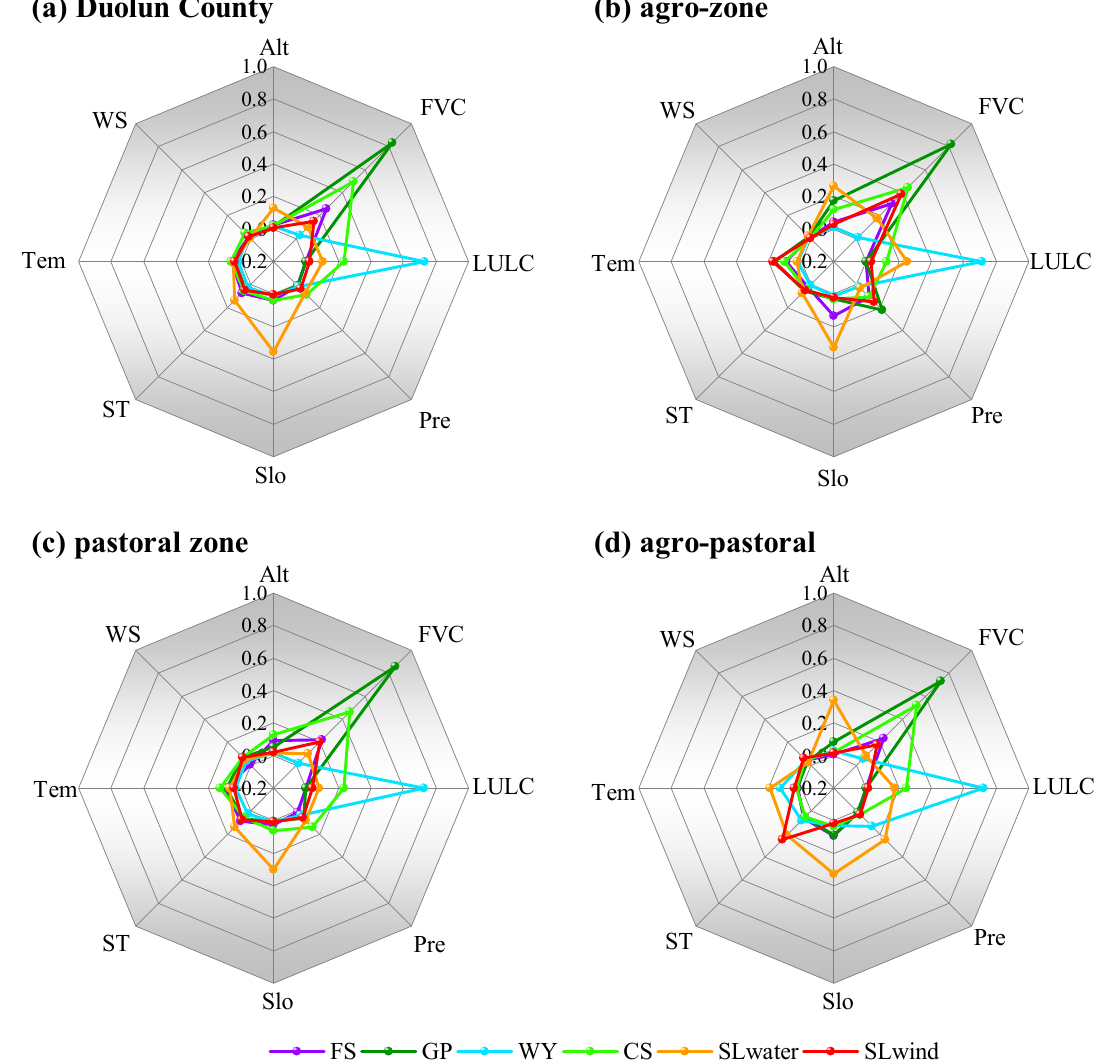
Figure 9. The q values of drivers affect the spatial distributions of ESs in Duolun County and different zones. The drivers include precipitation (Pre), temperature (Tem), wind speed (WS), soil type (ST), altitude (Alt), slope (Slo), vegetation cover (FVC), and land use/cover (LULC). ( a ) The q values of drivers affecting the spatial distributions of the ESs (FS, GP, WY, CS, SLwater, and SLwind) in Duolun County. ( b ) The q values of drivers affecting the spatial distributions of the ESs (FS, GP, WY, CS, SLwater, and SLwind) in the agricultural advantage zone (agro-zone). ( c ) The q values of drivers affecting the spatial distributions of the ESs (FS, GP, WY, CS, SLwater, and SLwind) in the pastoral advantage zone (pastoral zone). ( d ) The q values of drivers affecting the spatial distributions of the ESs (FS, GP, WY, CS, SLwater, and SLwind) in the semiagricultural and semipastoral zone (agro-pastoral zone). FS: food supply, GP: grass production, WY: water yield, CS: carbon sequestration, SLwater: soil water erosion, SLwind: soil wind erosion. The dominant drivers for the distributions of ESs in the three zones remained con- sistent with those of the county, and the importance of the other drivers changed with the ecological production zone. FVC was the dominant driver in the distributions of FS and GP in each ecological production zone. Furthermore, in the agro-zone, Slo (q = 0.136) and Pre (q = 0.104) contributed more to the distributions of FS, and Pre (q = 0.221) and Alt (q = 0.175) contributed more to the distributions of GP. In the pastoral zone, Tem (q = 0.097) and Alt (q = 0.094) had greater explanatory powers for FS, and Tem (q = 0.091) and WS (q = 0.071) had greater explanatory power for GP. The Slo had a greater explanatory power